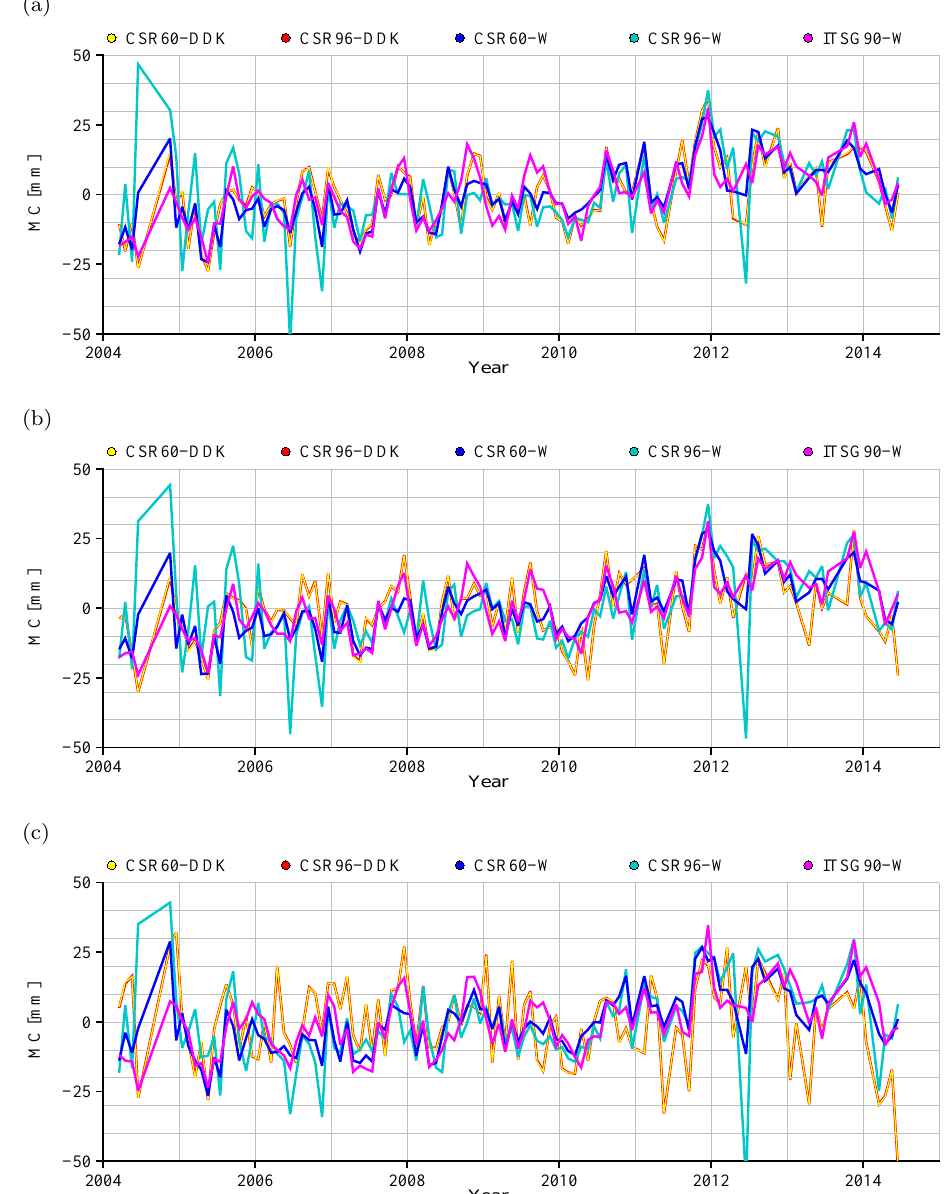
Figure 7. Sub-basin-scale time series of the MC using various filters for three polygons with different orientation: zonal (a) , square (b) and meridional (c) . Red and yellow represent the CSR60-DDK and the CSR96-DDK solutions. The blue and light blue time series represent, respectively, the CSR60-W and the CSR96-W solutions. In purple are the time series of the ITSG90-W